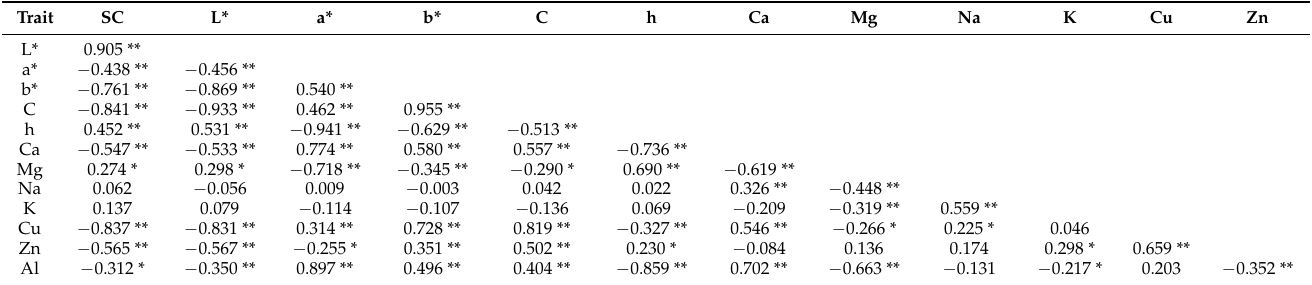
Table 6. The Spearman’s correlation coefficients between parameters of eggshell color and its mineral composition.